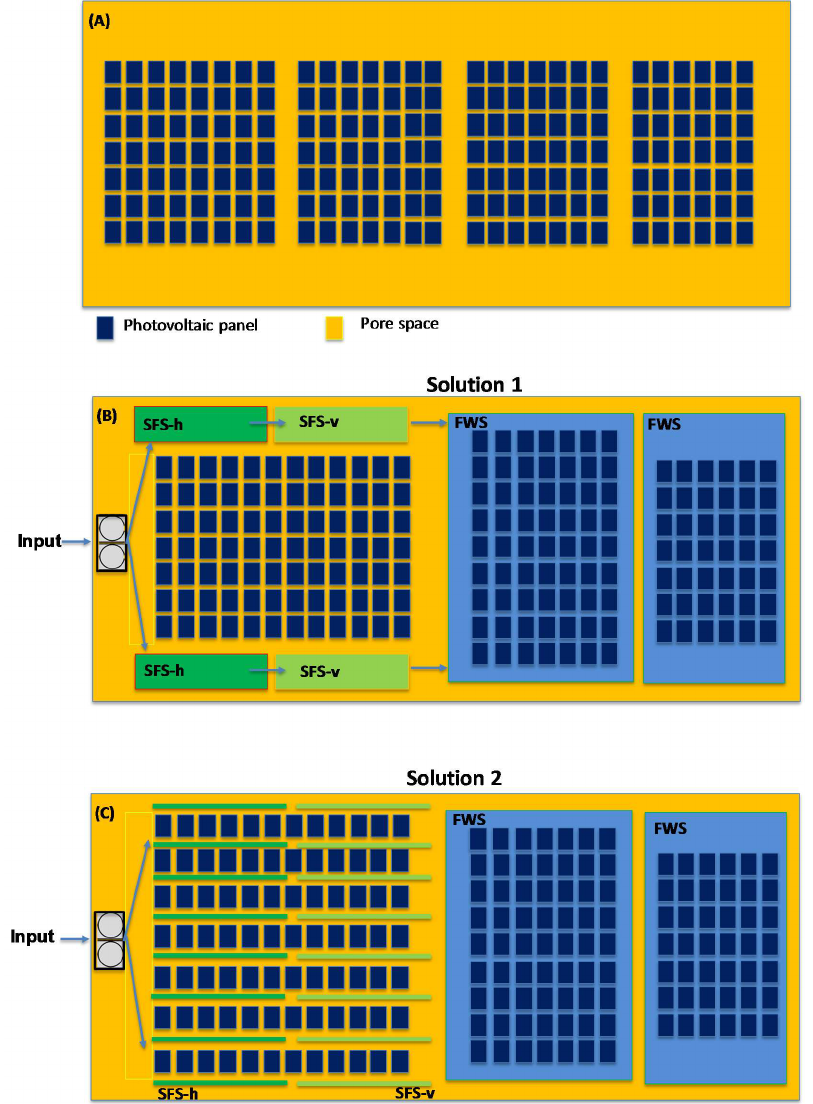
Figure 6. ( A ) Current GPV systems considered as a case study, and proposed Solutions 1 ( B ) and 2 ( C ) Figure 6. ( a ) Current GPV systems considered as a case study, and proposed Solutions 1 ( b ) and 2 ( c ) integrated with CTWs. integrated with